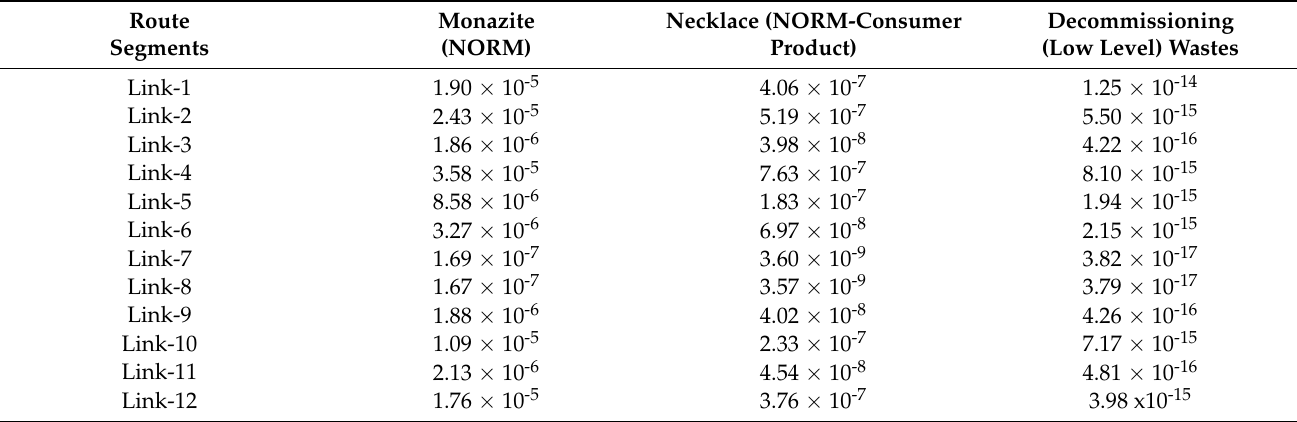
Table 7. Comparison of population dose from fire transport accidents involving NORM and low level.